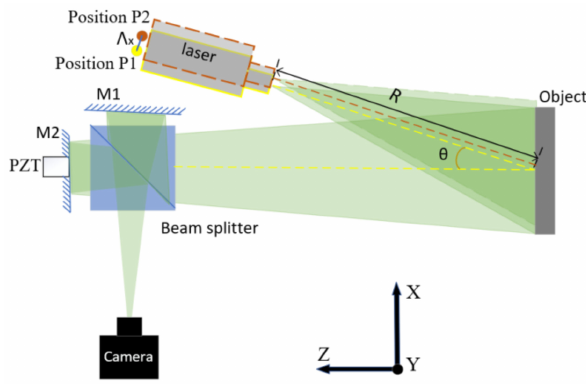
Figure 1. One-dimensional digital shearography with source